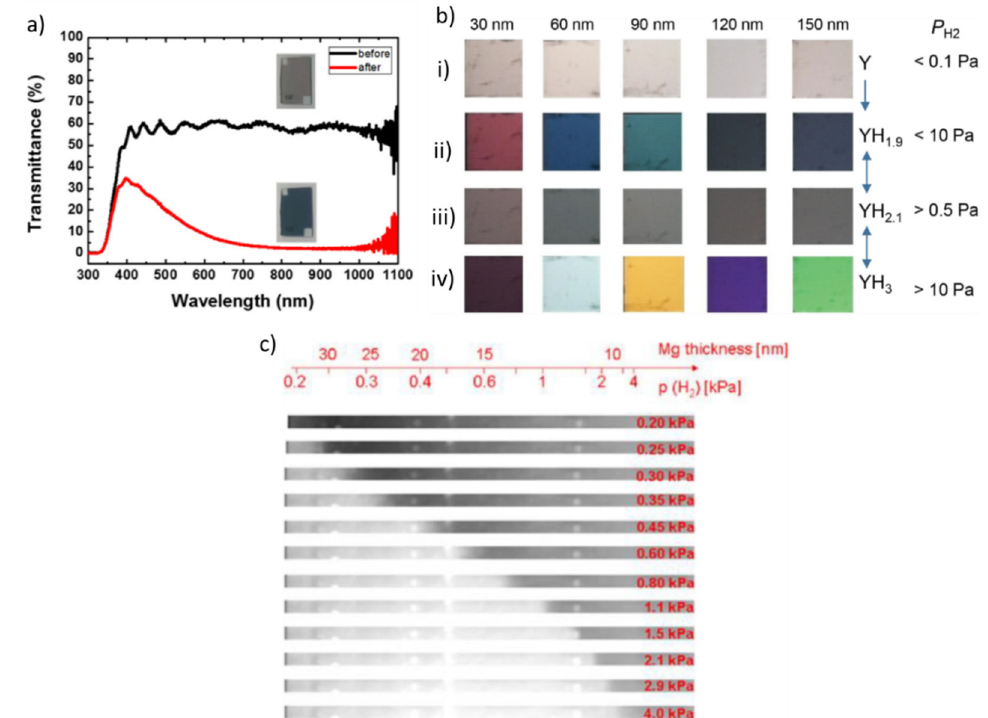
Figure 3. ( a ) Transmittance spectra of a 760 nm thick WO 3 layer, capped with a Pd layer of 4 nm, before (black curve) and after (red curve) 10 min exposure to 1% H 2 in air containing oxygen, water vapors, and nitrogen. Reproduced from [60], with permission from Elsevier, 2017. ( b ) Colors of Pd-capped Y thin films that have been exposed to different concentrations of H 2 at room temperature. Adapted from [37], with permission from JPS, 2020 ( c ) Colors and resulting thickness of Pd-capped Mg films exposed to H 2 pressures ranging from 0.2 to 4 × 10 3 Pa. Mg becomes highly transparent when converted to MgH 2 . Reproduced from [64], with permission from Elsevier, 2010.